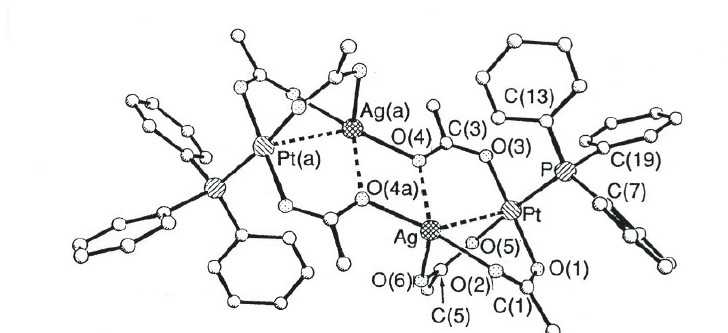
Figure 6. Structure of [(PPh